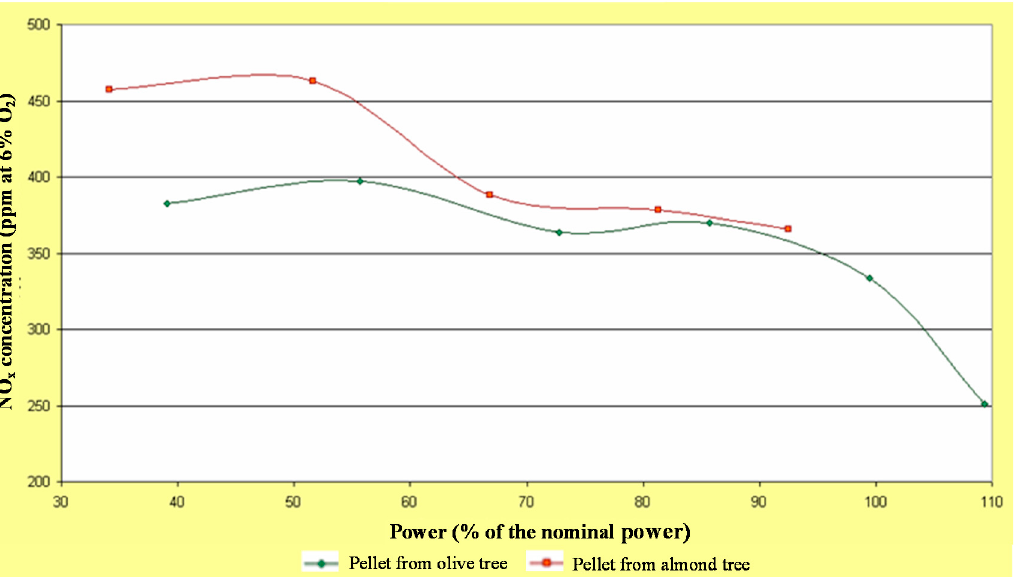
Figure 4. Evolution of NO x emissions depending on the partial operating load during combustion tests with pellets from almond and olive trees.